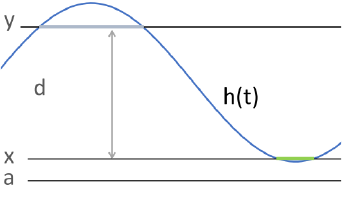
Figure 4. Constant limits and